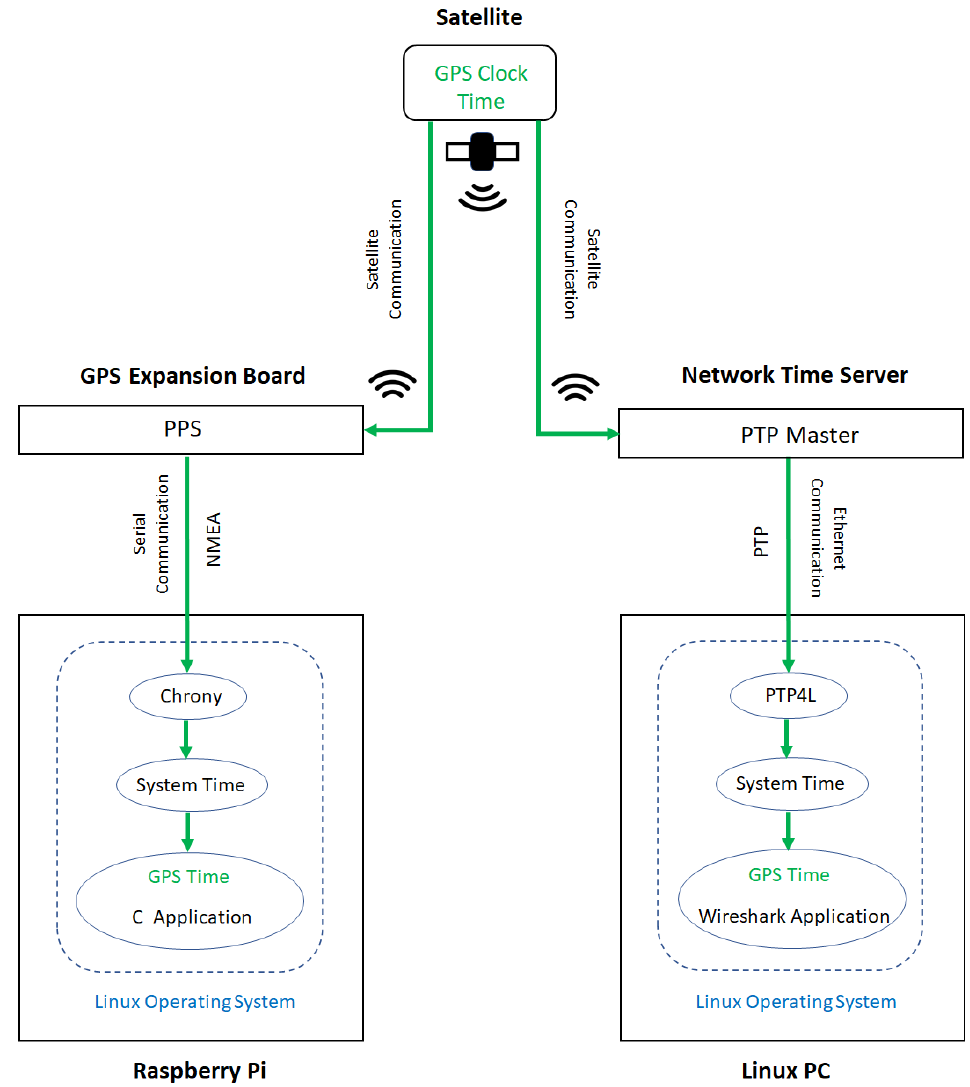
Figure 20. GPS time synchronization of sender (Raspberry Pi) and receiver (Linux PC).